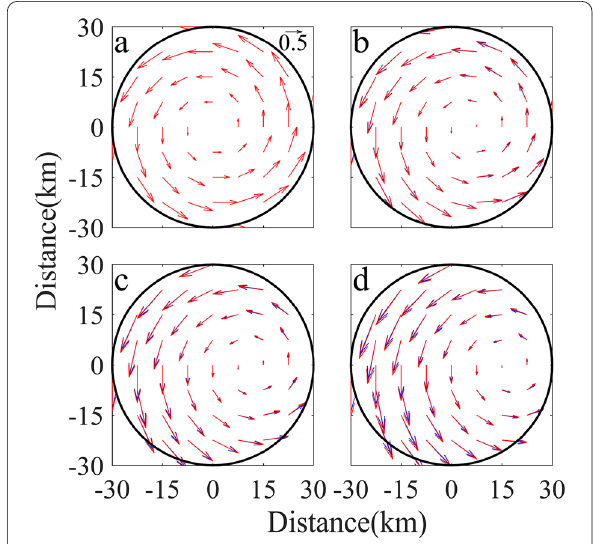
Fig. 1 Spatial distribution of eddy velocity. a t = 0 h ; b t = 4 h ; c t = 8 h ; d t = 12 h . Red arrows and blue arrows indicate eddy velocity using the equations of absolute wind stress and relative wind stress, respectively (Unit: m · s − 1